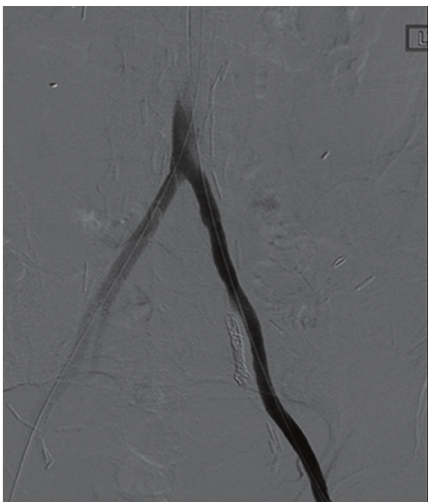
Figure 4: Left iliac arteriogram after left internal iliac embolization and placement of an 8mm × 5cm Gore (cid:2) Viabahn (cid:2) stent from the mid left common iliac artery to the proximal external iliac artery shows no opacification of the left internal iliac artery and elimination of the left internal iliac arterioureteral